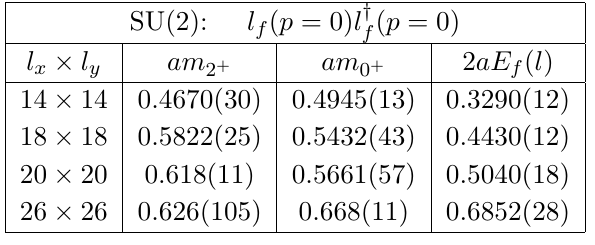
Table 3 . Energies of lightest J P = 2 + ; 0 + states formed from the product of a pair of (conjugate) winding (cid:13)ux tube operators on various l x (cid:2) l y spatial lattice volumes. Also twice the energy E f ( l x ) of the lightest fundamental (cid:13)ux tube that winds around the x -torus. In SU(2) at an inverse bare coupling (cid:12) = 4 =ag 2 = 12 :